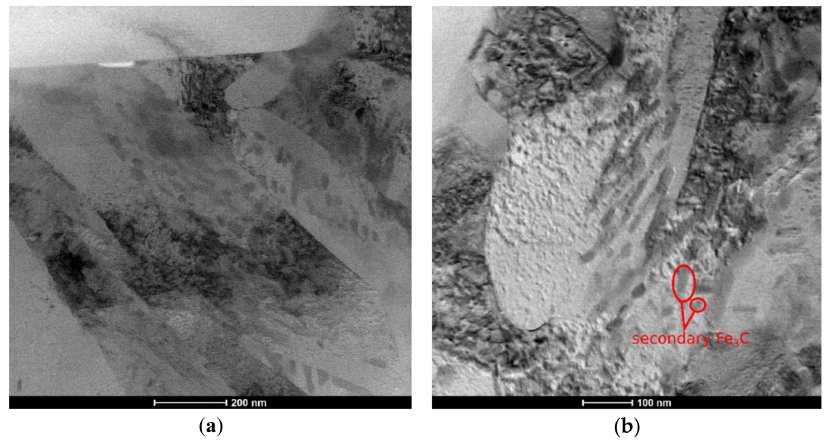
Figure 9. The microstructure of the matrix of in situ composite laser-alloyed surface layer, HAADF- STEM. ( a ) is the matrix microstructure; ( b ) is the detailed view of the microstructure and the secondary Fe 3 C.